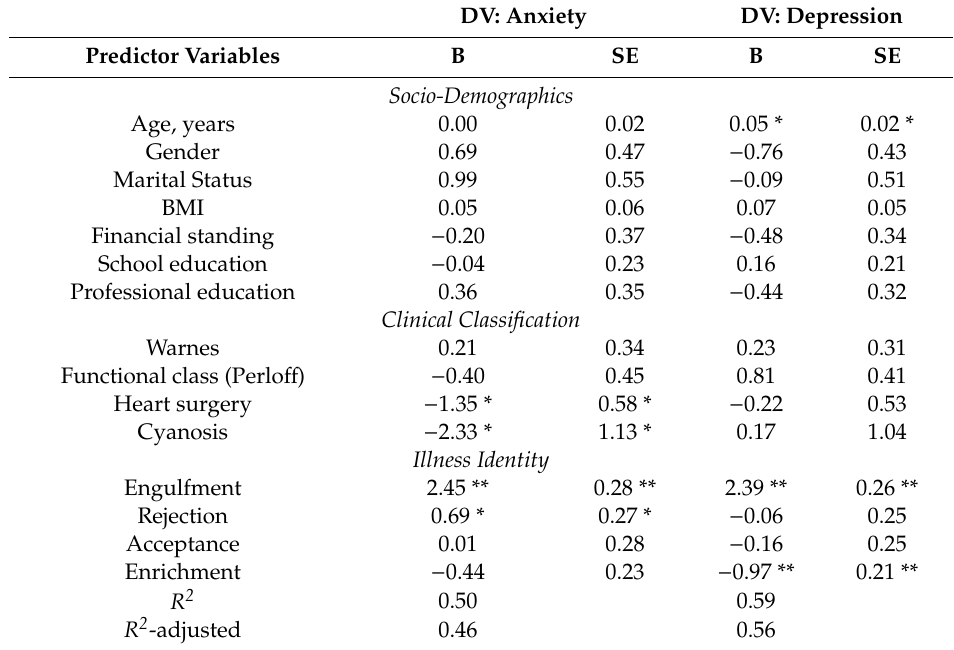
Table 6. Results of Multiple Regression Analysis Using Anxiety and Depression as Dependent Variables